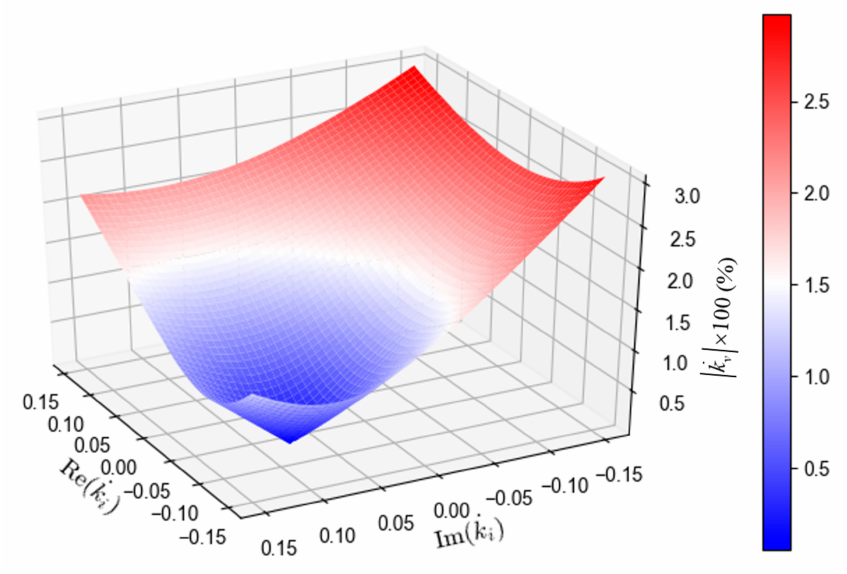
Figure 9. Voltage unbalance rate when line impedance is